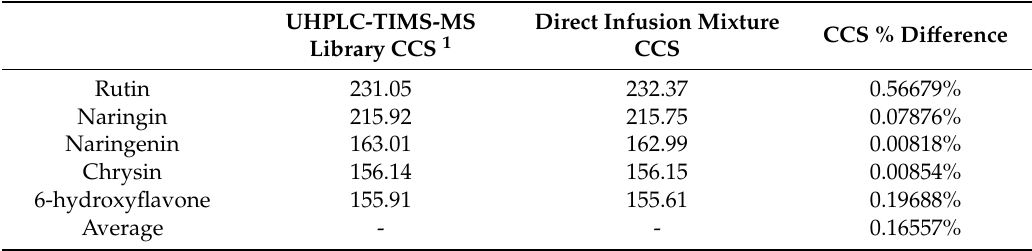
Table 1. Differences of CCS values between the compounds analyzed by direct infusion and by UHPLC-trapped ion mobility spectrometry coupled to tandem mass spectrometry (UHPLC-TIMS- TOF-MS). This table uses Stow et al. 2017 [29] Calibration reference.